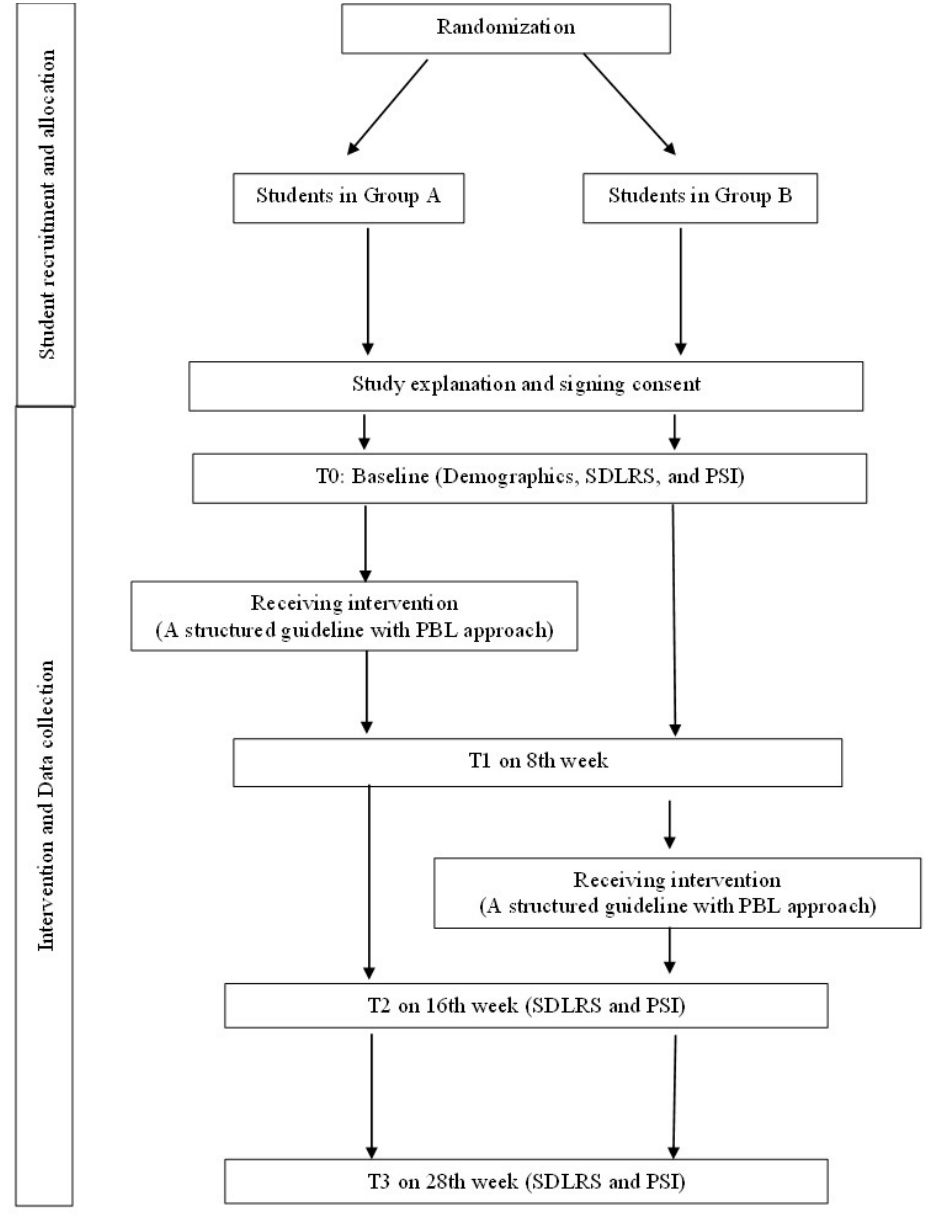
Figure 2. Flow diagram of student recruitment and